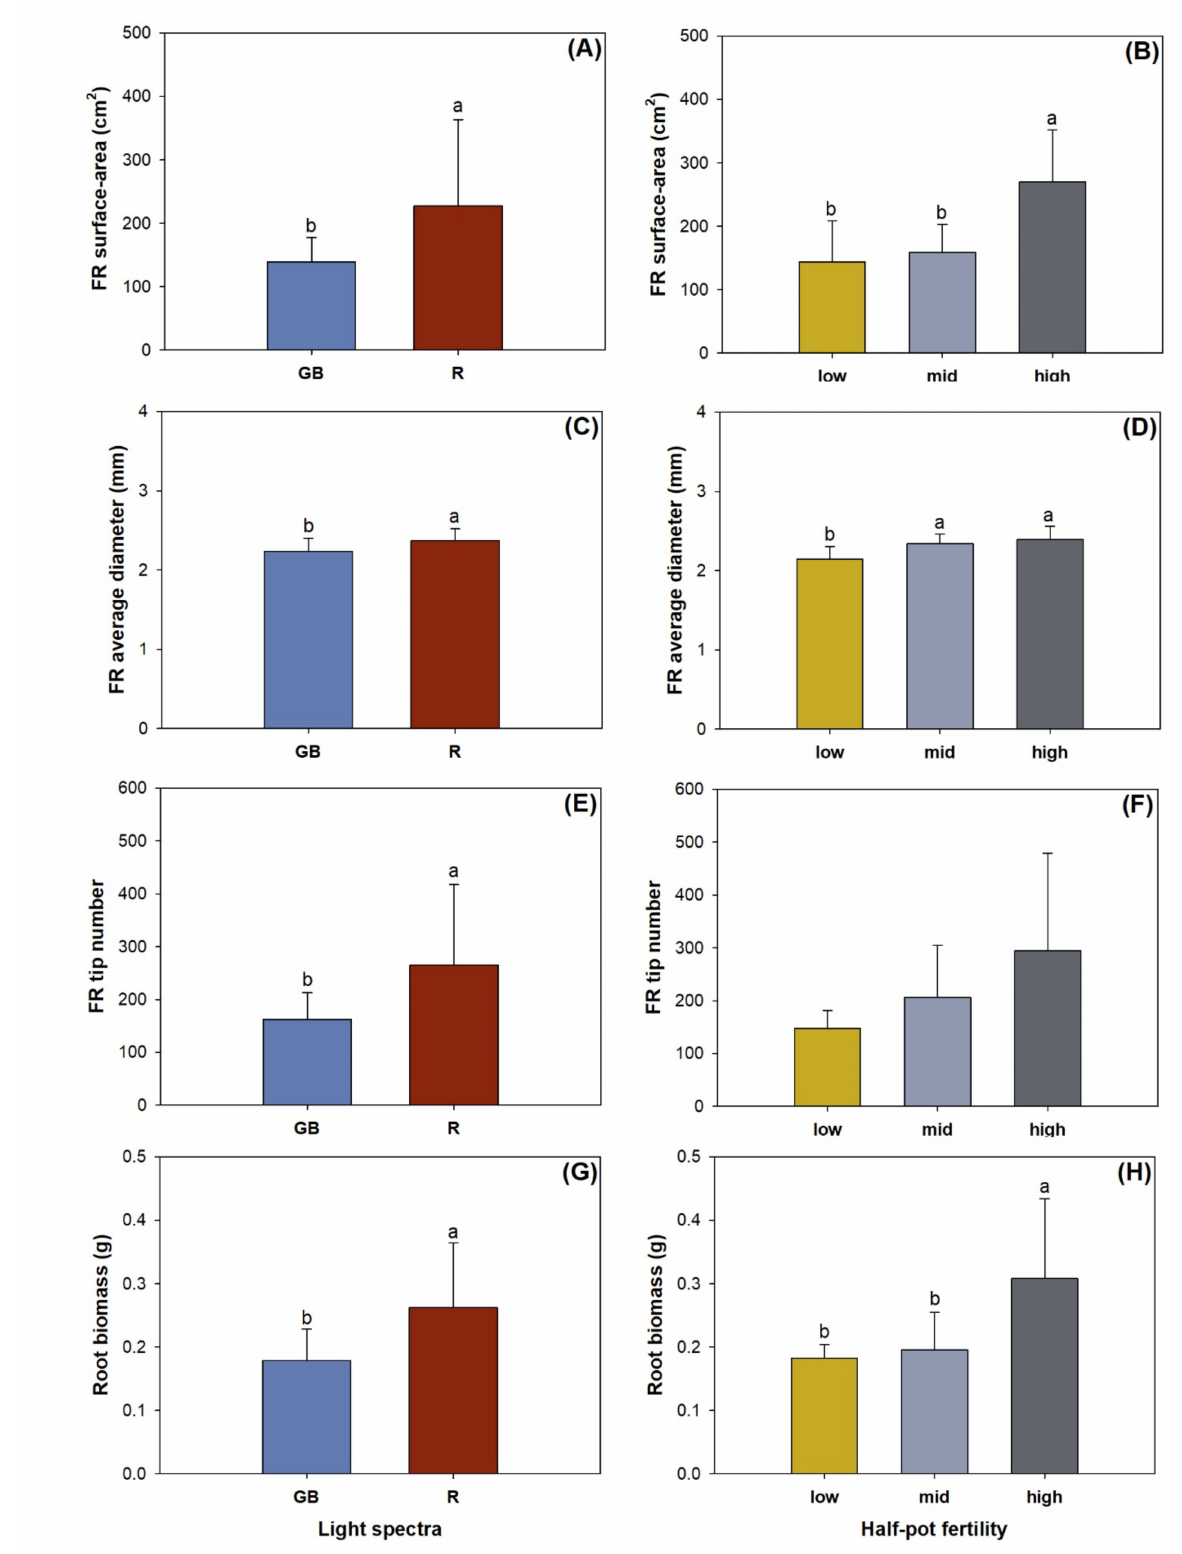
Figure 5. Fine root (FR) surface area ( A , B ), average diameter ( C , D ), tip number ( E , F ), and biomass ( G , H ) in Pinus pumila seedlings subjected to green-and-blue light (GB) and red-light enriched spectra (R) in low, middle, and high half-pot fertilities. Error bars indicate standard deviations. Different letters above the bars indicate significant differences according to Duncan test at the 0.05